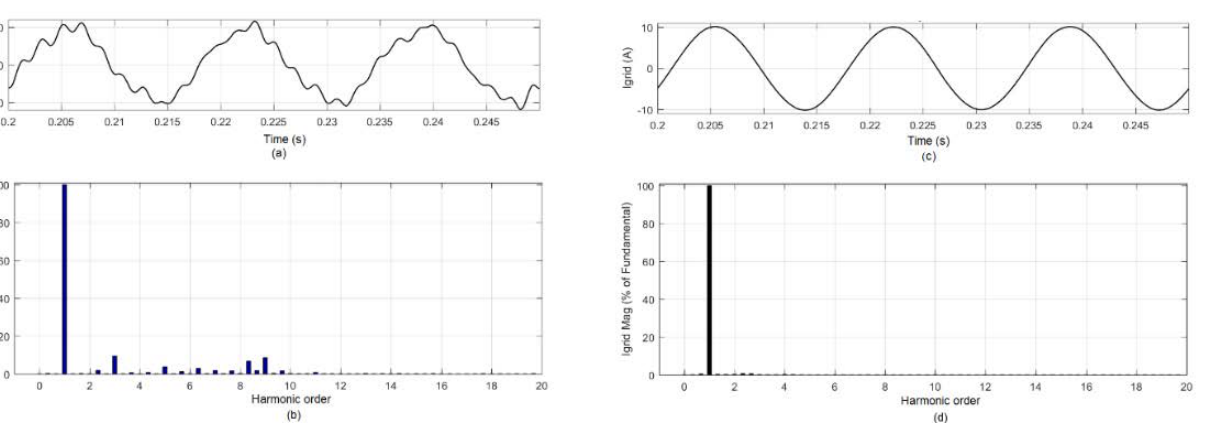
Table 2. Odd harmonic grid current distortion in percent of the fundamental component without APF.